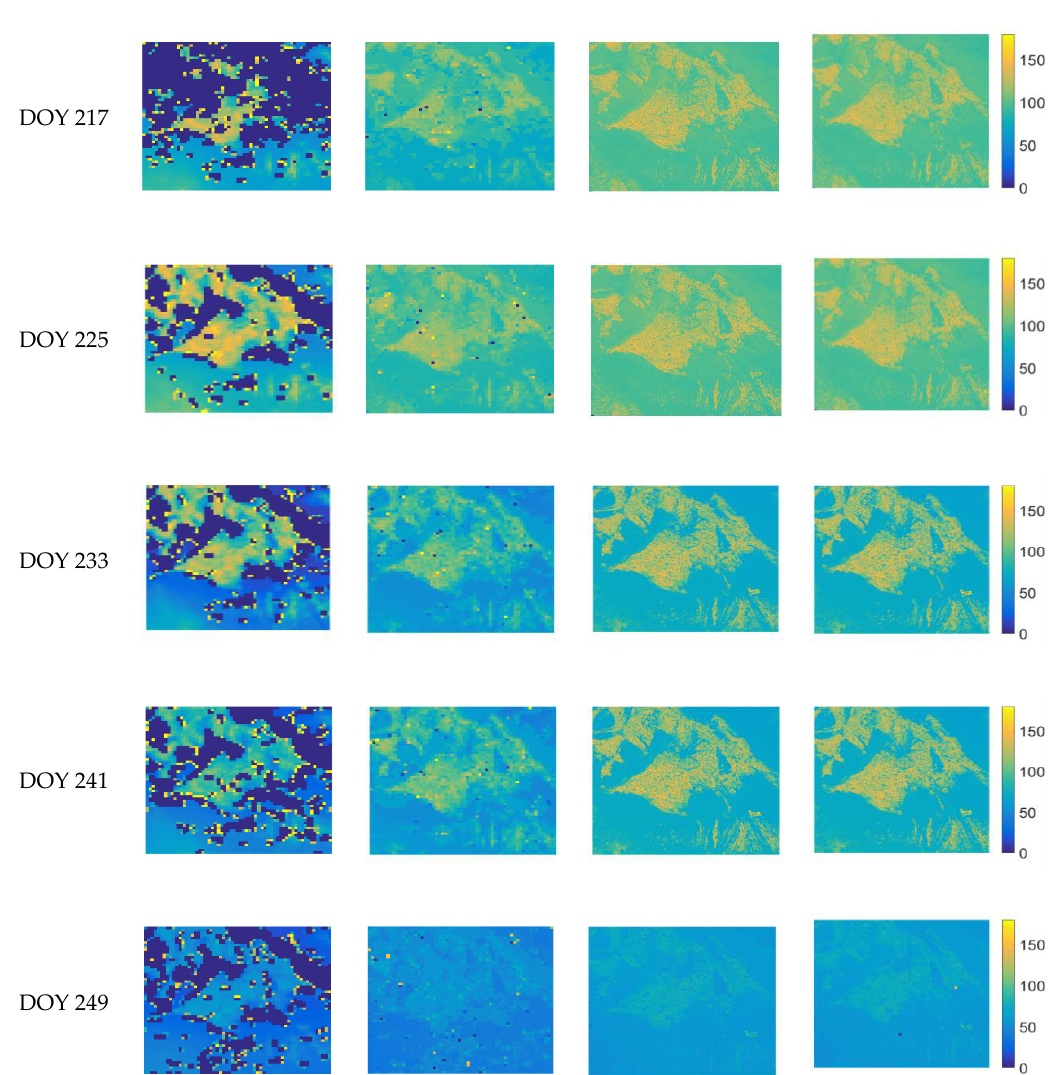
Figure 4. The integration comparison before and after MKF for DOY (day of year) 225, DOY 233, DOY 241, and DOY 249 in 2012. The order, from left to right, is the LE from original MODIS, MKF-integrated MODIS, original Landsat, and MKF-integrated Landsat. Dark blue color means no data.